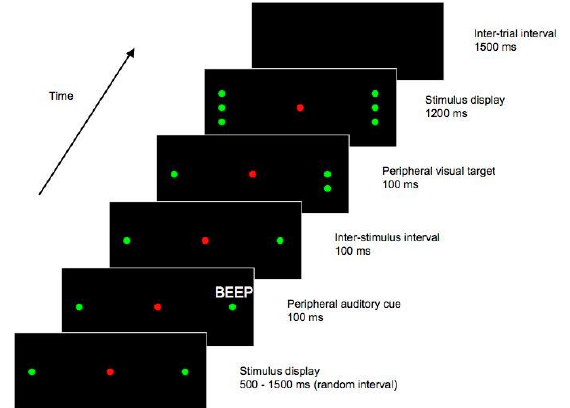
Figure 3: Stimulus sequence from Experiment 2. This figure shows one possible trial type, in which the target appears ipsilateral to the cue. In this example, the auditory cue is emitted from the right hand side of the display, and the subsequent target is presented on the right. Both cues and targets could also be presented on the opposite side of the display to that shown here, and the target could also appear above the central placeholder LED, rather than below as shown here. Figure not to scale.